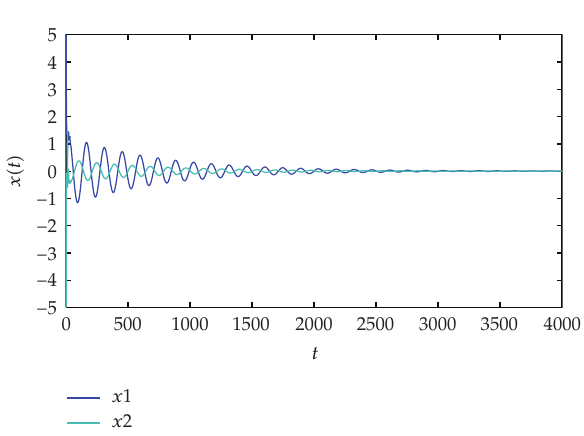
Figure 4: State trajectories of system (cid:2) 12 (cid:3) with cc (cid:9) 0 . 4 , τ 1 (cid:9) τ 2 (cid:9) h (cid:9) 1 . 97 , E a (cid:9) E b (cid:9) E d (cid:9) 0 .